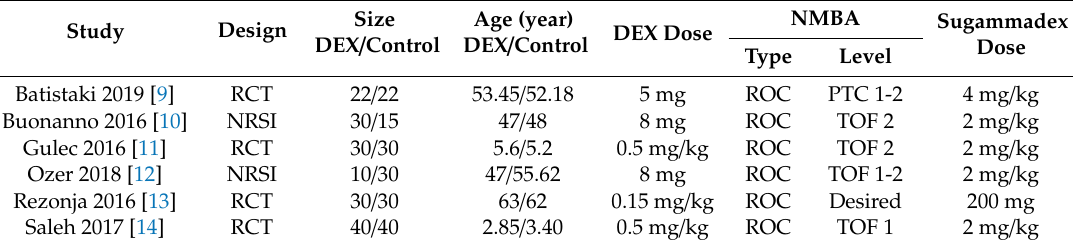
Table 1. Baseline characteristics and population of the included trials ( n =